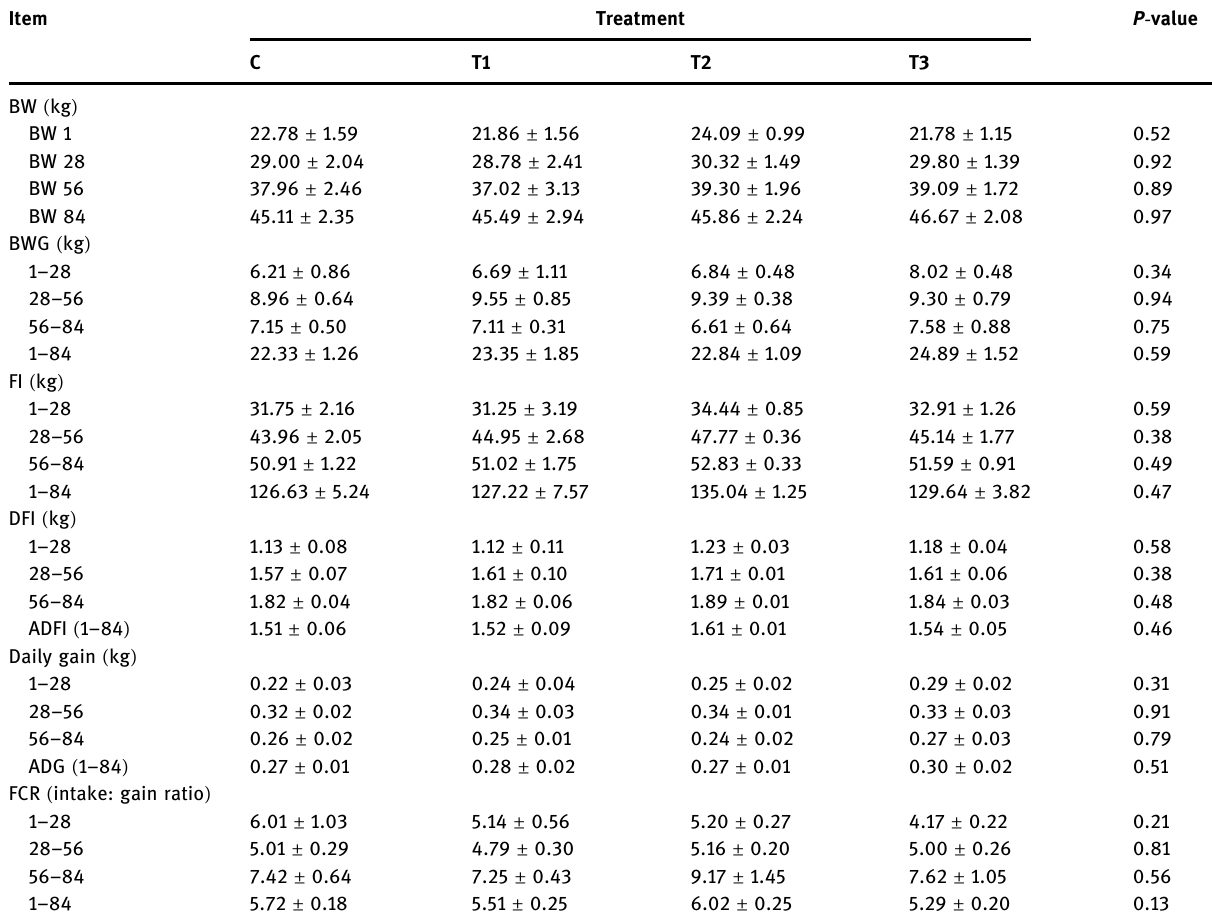
Item Treatment P -